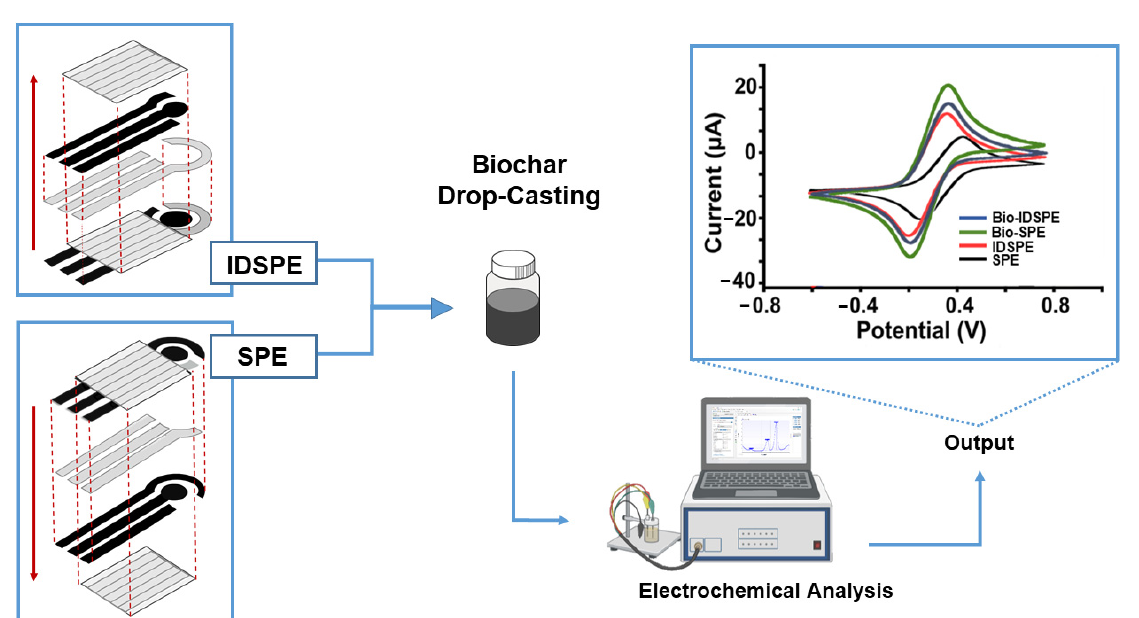
Figure 7. Two different configurations of serigraphic platforms and enhancing effect of the biochar.